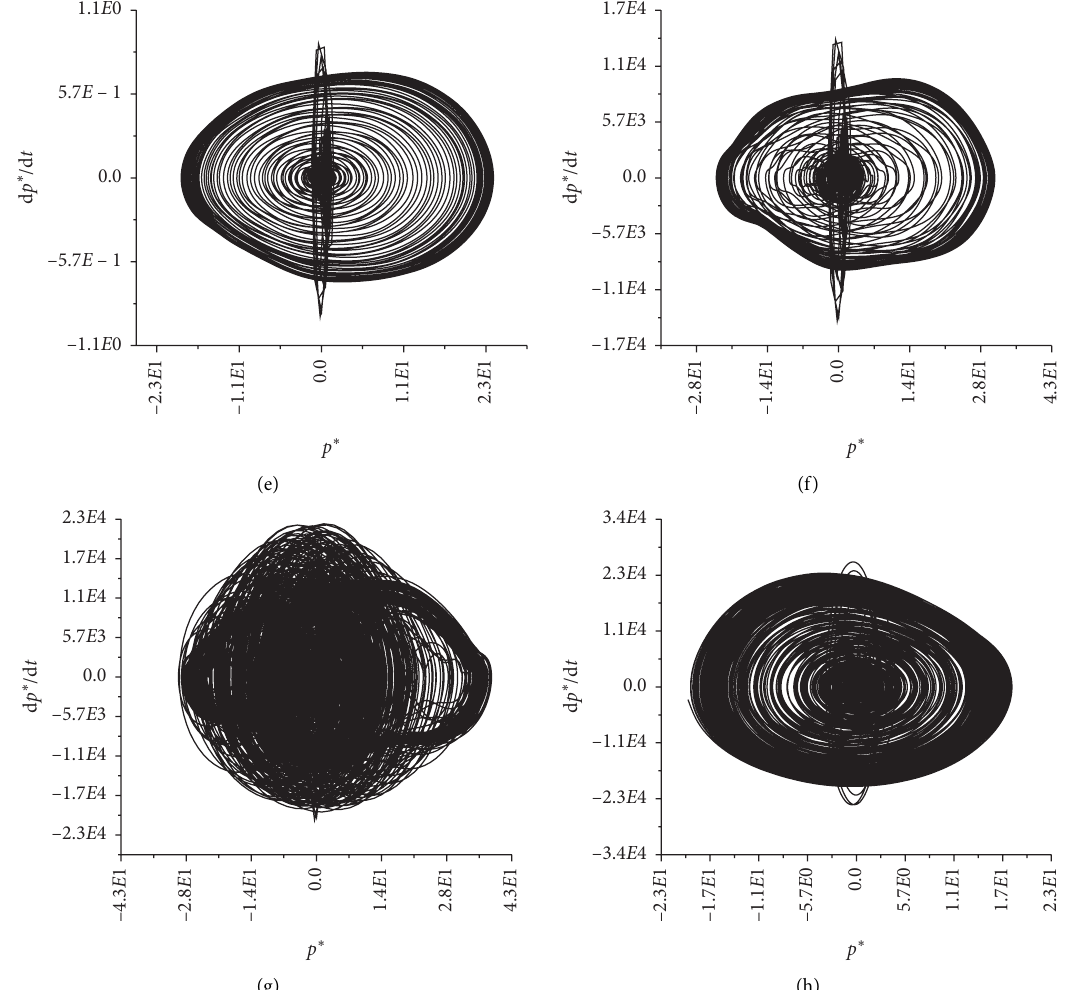
Figure 16: Phase plane: (a) v � 10 m/s, (b) v � 15 m/s, (c) v � 20 m/s, (d) v � 30 m/s, (e) v � 40 m/s, (f) v � 50 m/s, (g) v � 60 m/s, and (h) v � 70